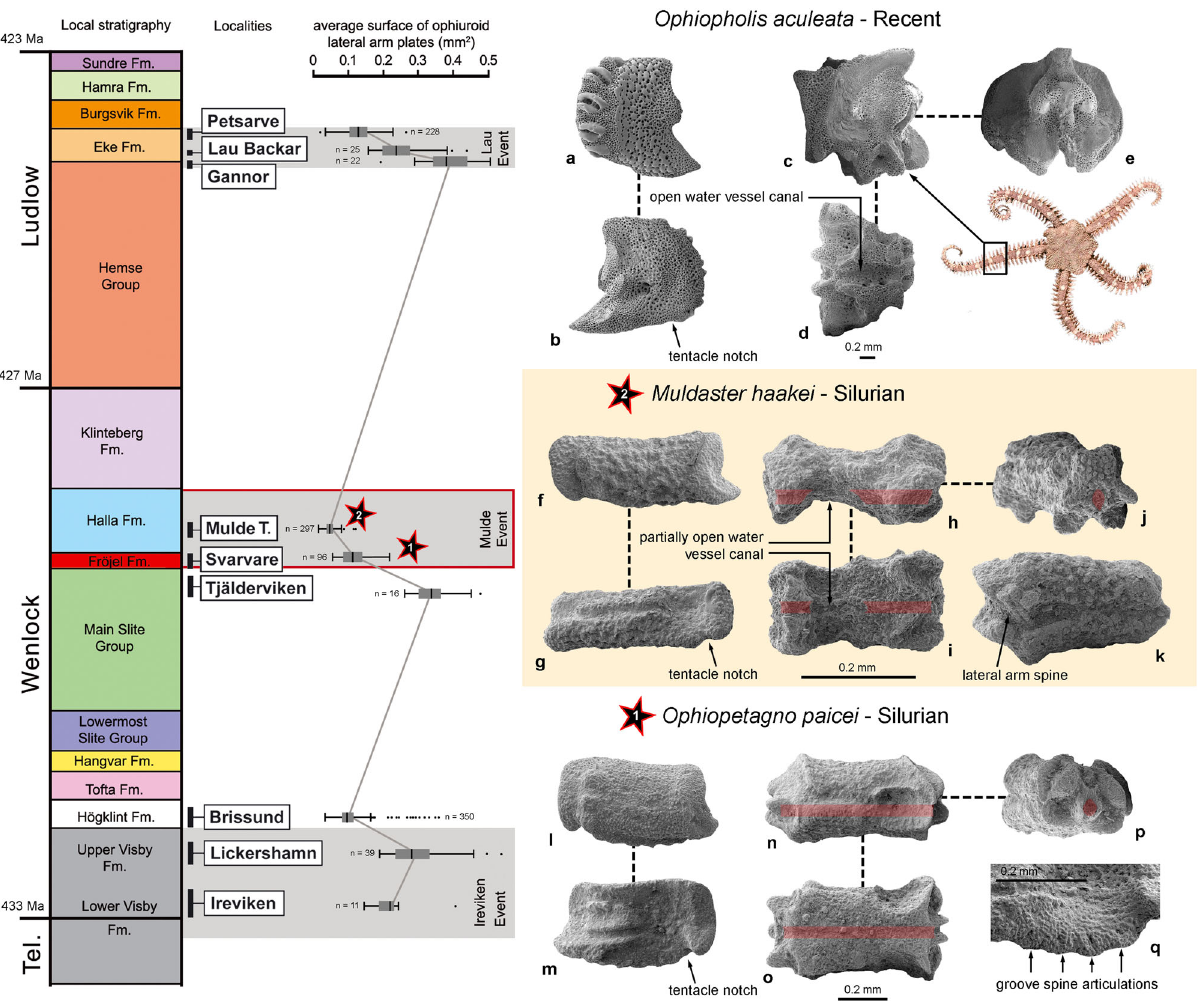
Fig. 1 Arm plates of Ophiopetagno paicei and Muldaster haakei from the Silurian of Gotland, Sweden, in comparison to a living relative ( Ophiopholis aculeata ), and in the context of the local stratigraphic framework 12 with localities sampled (Mulde T.: Mulde Tegelbruk), palaeoenvironmental events, and trends in average surface area of the lateral arm plates as an approximation for body size. Ophiopholis aculeata : lateral arm plate in external ( a ) and internal ( b ) views. Vertebra in lateral ( c ), ventral ( d ), and distal ( e ) views. Muldaster haakei : Specimen MnhnL OPH088 (all numerical codes in the fi gure legend refer to specimen numbers in the MnhnL collection), holotype of M. haakei . Lateral arm plate in external ( f ) and internal ( g ) views. Specimen OPH089. Vertebra in lateral ( h ), ventral ( i ), and distal ( j ) views. k Specimen OPH090. Arm segment in ventral view. Ophiopetagno paicei : Specimen OPH087. Lateral arm plate in external ( l ) and internal ( m ) views. Specimen OPH092. Vertebra in lateral ( n ), ventral ( o ), and distal ( p ) views. q Specimen OPH93. Lateral arm plate, detail of tentacle notch in internal